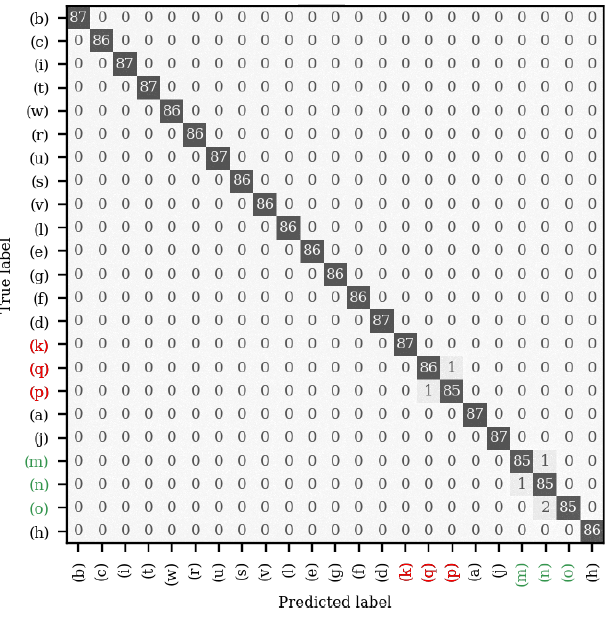
Figure 8. The confusion matrix for one of the five mel-spectrogram CNNs making predictions on the test set. Highlighted for convenience are the two groups of objects where erroneous predictions were made: in red, (k), (p) and (q) are the table tennis balls; in green, (m), (n) and (o) are the tennis